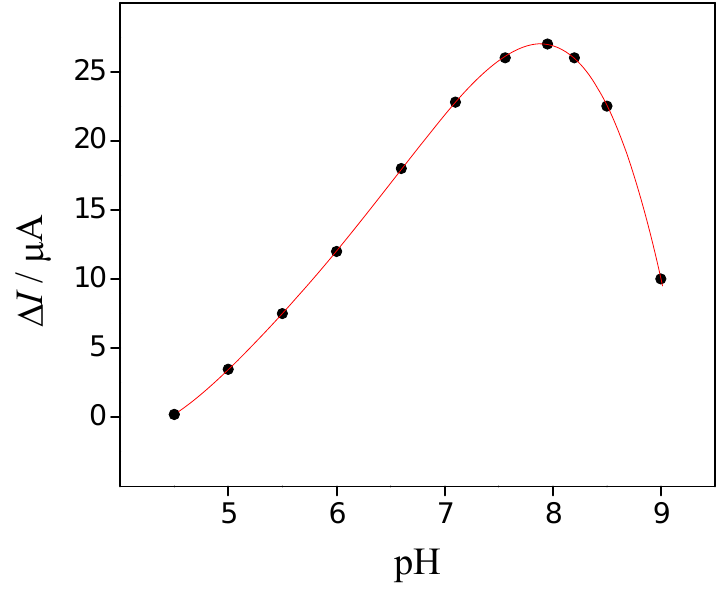
Figure 4. pH dependence of the voltammetric response of the sensor in a TRIS buffer solution of different pHs in presence of 4.8 × 10 − 4 mol L − 1 potassium ions. Scan rate = 50 mV s − 1 . The anodic peak current ( Δ I / μ A) was obtained by the difference pa of the currents in the presence and absence of potassium